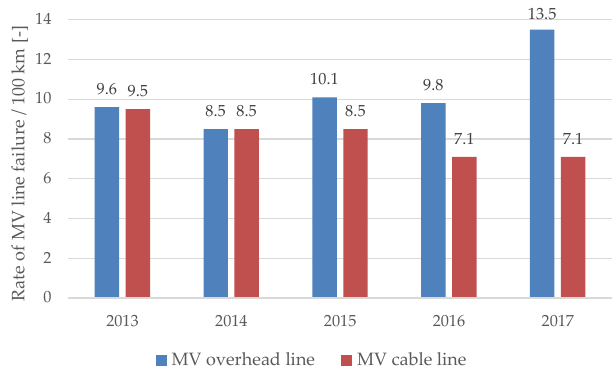
Figure 1. MV line damage indicator per 100 km in 2013–2017 in Poland [2].